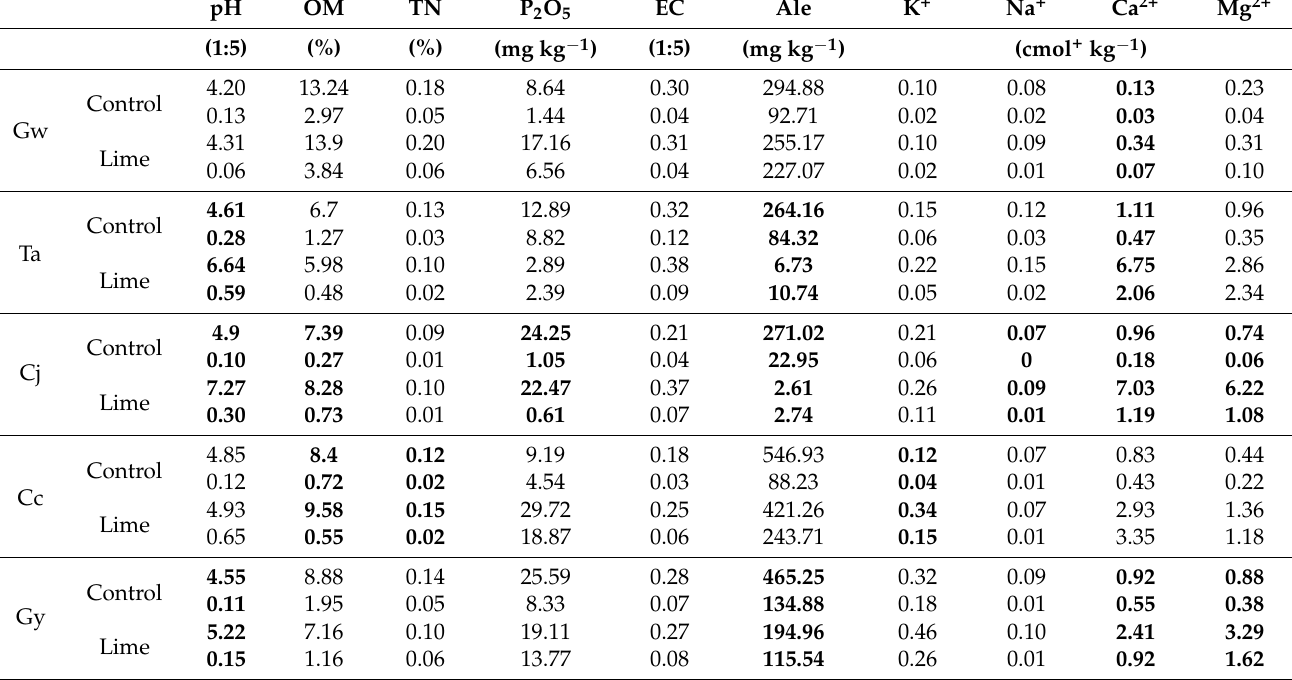
Table 1. Soil chemical properties of study